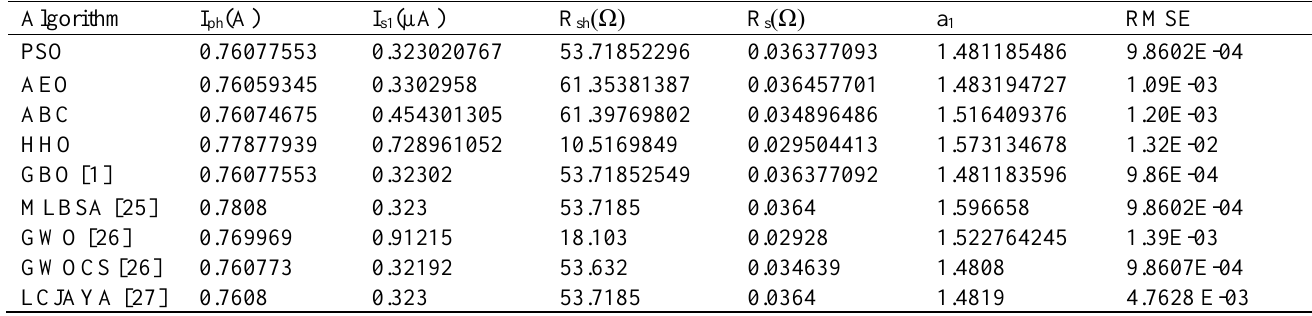
Estimated parameters for single diode model at the best root mean square error (RMSE).